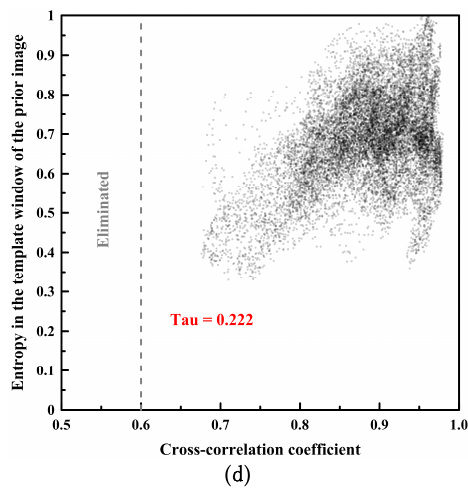
Figure 10. The relationships (Kendall’s tau coefficient) between the cross-correlation coefficient and sea ice image properties using the same image pairs as Figures 5 and 8: ( a ) cross-correlation coefficient vs. sea ice coverage of the image blocks from the prior image of the spatial resolutions of 4 m; ( b ) cross-correlation coefficient vs. entropy of the image blocks from the prior image of the spatial resolutions of 4 m; ( c ) cross-correlation coefficient vs. sea ice coverage of the image blocks from the prior image of the spatial resolutions of 15 m; and ( d ) cross-correlation coefficient vs. entropy of the image blocks from the prior image of the spatial resolutions of 15 m.